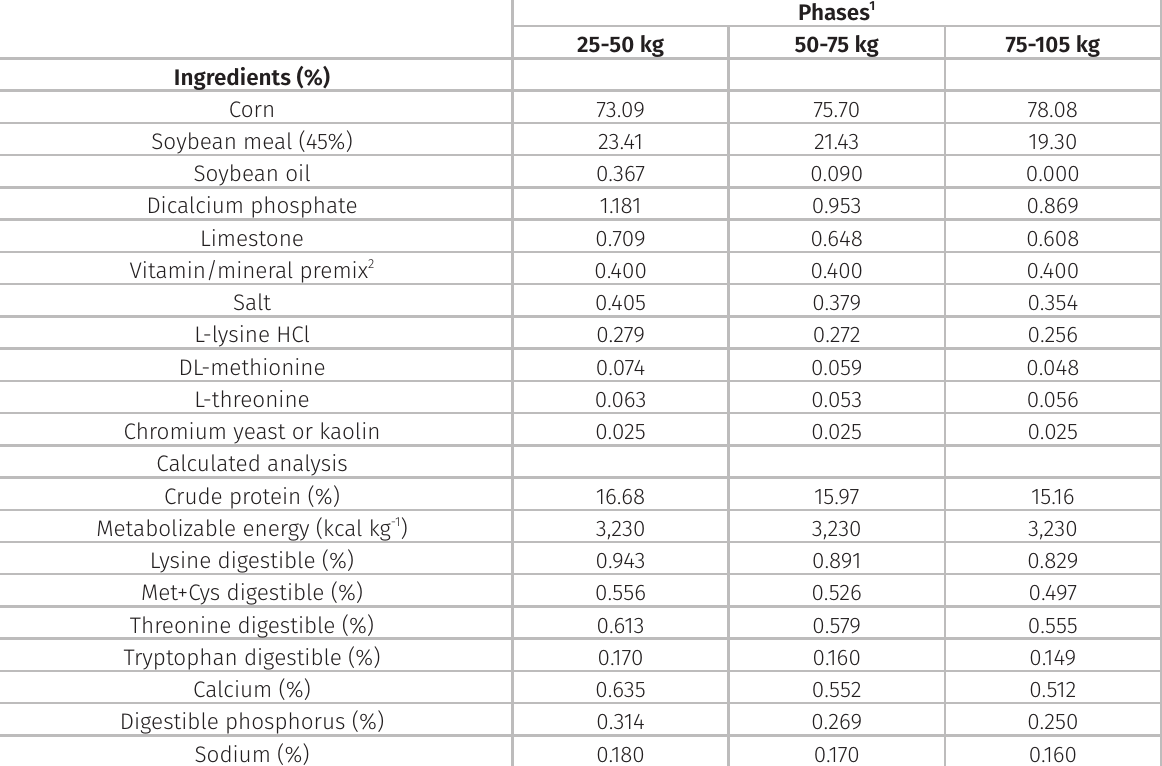
Table I. Composition of the experimental diets during the three